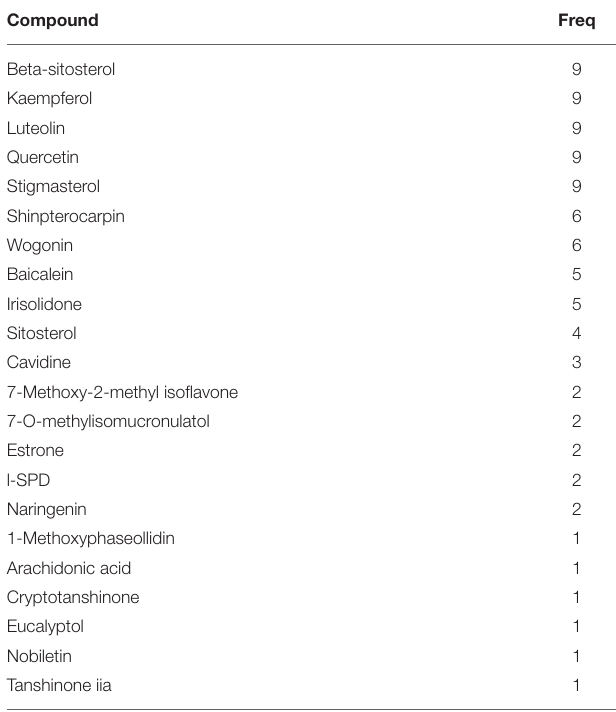
TABLE 5 | The frequency of occurrence of different compounds in nine prescriptions.